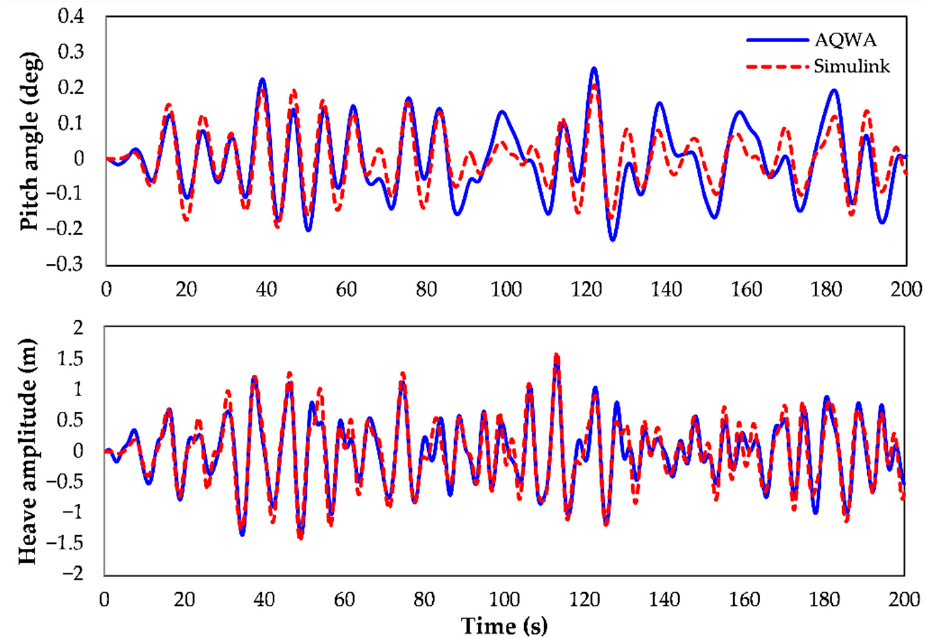
Figure 5. Conceptual design of hybrid system and wave energy converter.